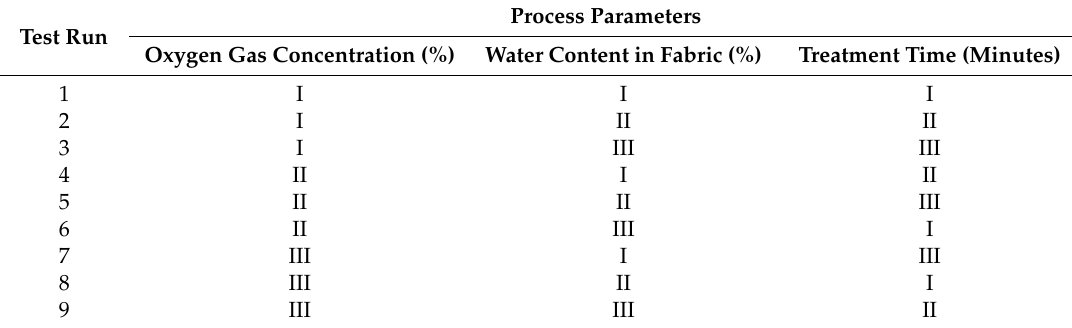
Table 3. Experimental